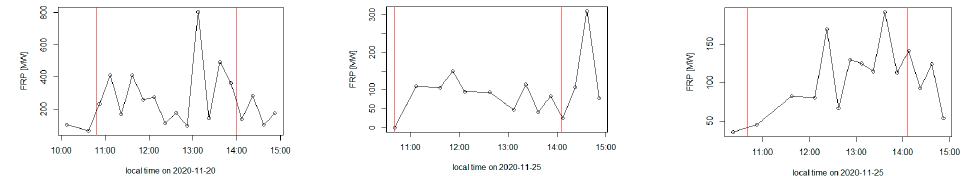
Figure 3. Summed Meteosat SEVIRI FRP over the fire front clusters depicted in Figures 1 and 2. Red vertical lines indicate the times of the S-2 (left line) and VIIRS (right line) overpasses which were used for the temporal integration and creation of the burned area envelopes.